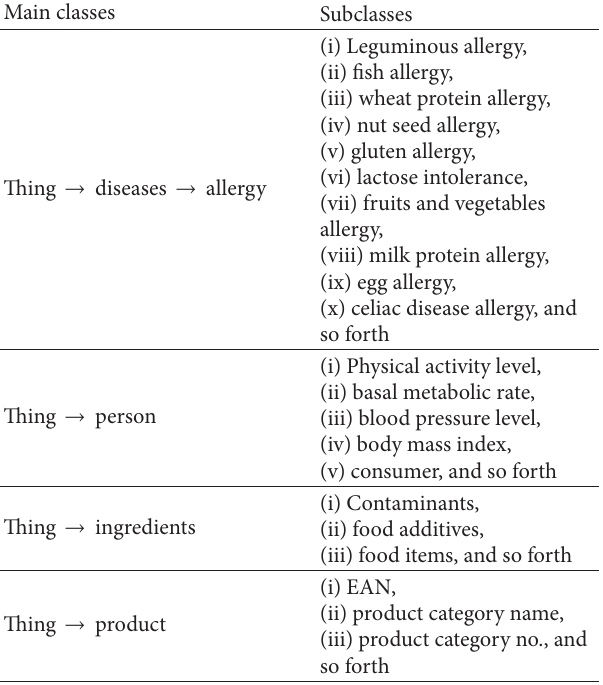
Table 1: Initial section of the food ontology knowledge base